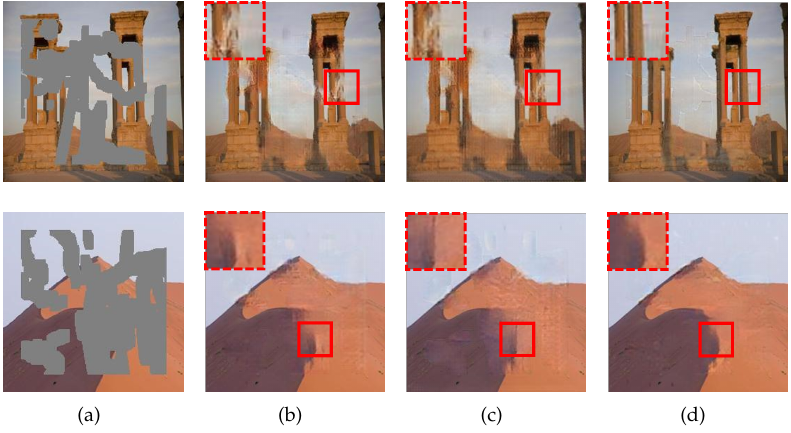
Figure 7. Qualitative results for the ablation study on the SE-based fusing module. The corruption rates, from top to bottom, are 32.9% and 42.2%, respectively. ( a ) Input images. ( b ) Resulting images for the random mode. ( c ) Resulting images for the uniform mode. ( d ) Resulting images for the SE